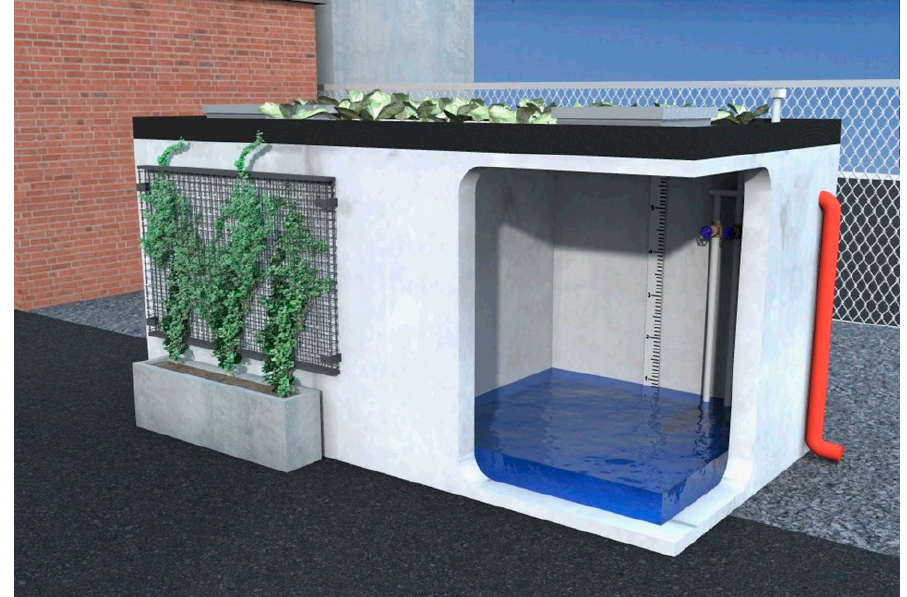
Figure 2. Cistern rendering showing concrete green tank structure with vegetated roof, planter with green screen and overflow pipe. Water 2018 , 10 , x FOR PEER REVIEW